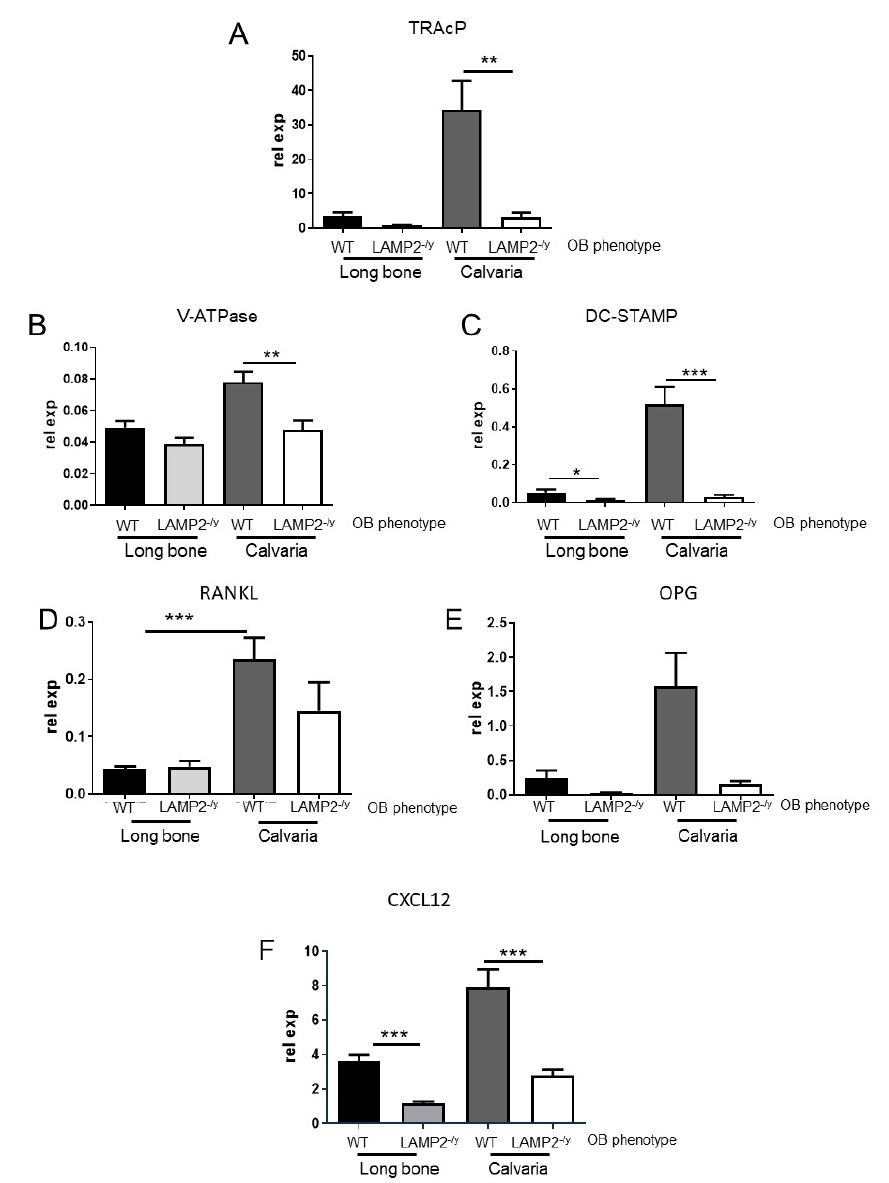
Figure 5. Expression of tartrate-resistant acid phosphatase (TRAcP), vacuolar- ATPase (v-ATPase), dendritic cell-specific transmembrane protein (DC-STAMP) and C-X-C motif chemokine 12 (CXCL12) is lower in co-cultures with LAMP-2 -/y osteoblasts. QPCR analysis was performed after 10 days of co-culture. Since no differences were found between the expression of bone marrow cells obtained from wild type or LAMP-2-/y mice, the data for co-cultures with wild type and LAMP-2-/y bone marrow and LAMP-2-/y were combined. Cultures with osteoblasts of LAMP-2-/y origin revealed a lower expression of ( A ) TRAcP, ( B ) v–ATPase in LAMP-2 -/y calvaria cultures and ( C ) DC-STAMP for both types of cultures ( n = 18 ± SEM, * p < 0.05, ** p < 0.01, *** p < 0.001). ( D ) RANKL expression was not significantly changed in the co-cultures with LAMP-2-/y osteoblasts ( n = 18). A significantly higher expression of RANKL was found between the calvaria and long bone co-cultures with WT osteoblasts, but not with LAMP-2-/y osteoblasts ( n = 18 ± SEM, *** p < 0.0001). ( E ) Osteoprotegerin (OPG) expression is lower in the co-cultures with LAMP-2-/y osteoblasts, being only significant for calvaria ( n = 5 ± SD, * p < 0.05). ( F ) CXCL12 expression is significantly lower in the co-cultures with LAMP-2-/y osteoblasts ( n = 18 ± SEM, *** p < 0.0005). 3.8. Expression of Osteoclastogenesis-Related Genes Is Affected in the Co-Cultures